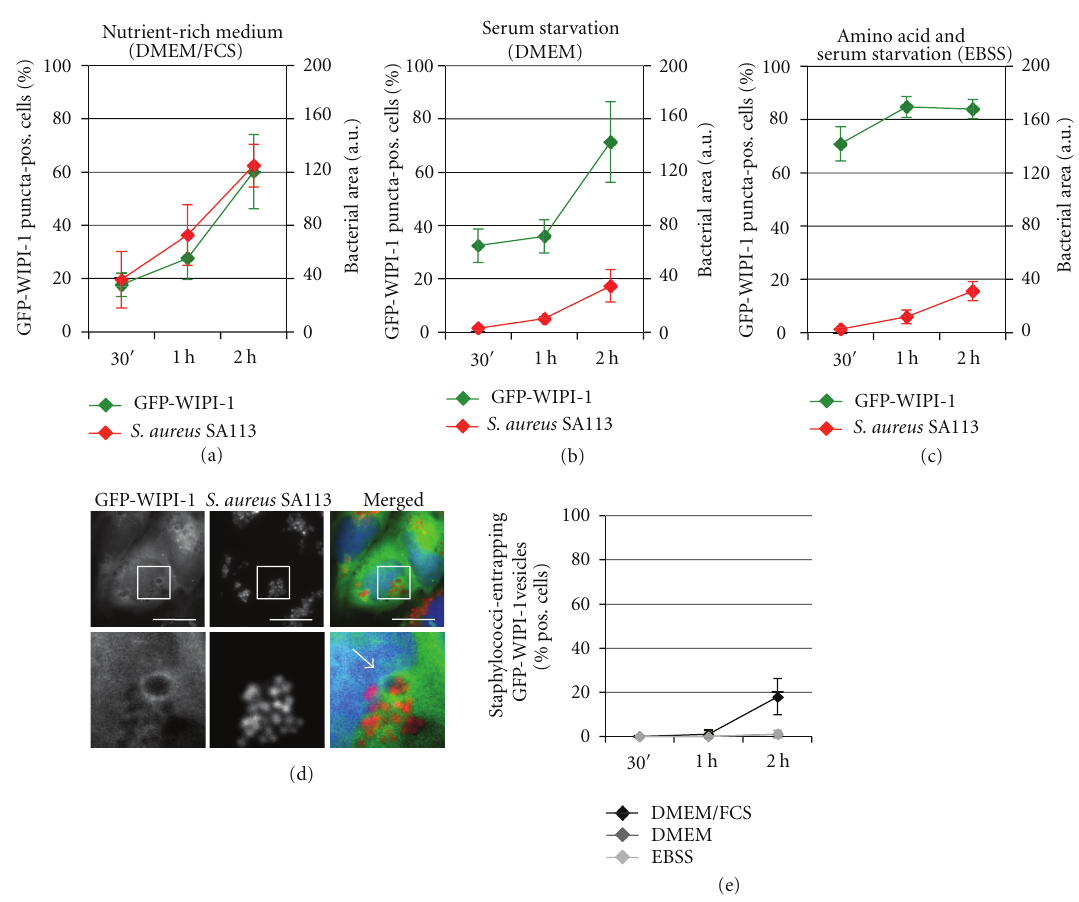
Figure 6: Pathogenic S. aureus SA113 induces GFP-WIPI-1 puncta formation and becomes entrapped in GFP-WIPI-1 positive autophagosome-like vesicles. According to Figures 4 and 5, GFP-WIPI-1 U2OS cells were infected with mCherry-expressing S. aureus SA113 in DMEM/FCS (a), DMEM (b), and EBSS (c) and analyzed (up to 2000 individual cells), representative images (2h, DMEM/FCS) are shown ((d), scale bars: 20 μ m), and the quantification of cells displaying GFP-WIPI-1 positive autophagosomal-like vesicles entrapping S. aureus SA113 is presented (e) ± SD ( n = 2, each in